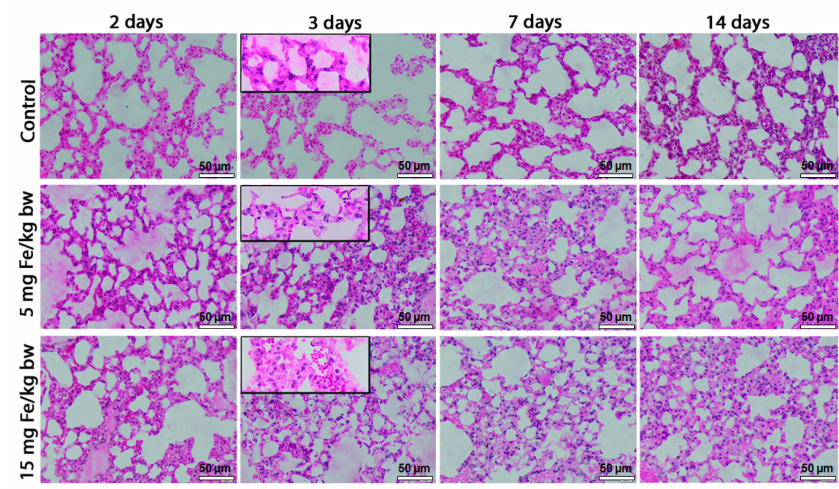
Figure 2. Histopathology of lung tissue after exposure to iron oxide nanoparticles coated with phospholipid-based polymeric micelles (IONPs-PM). Hematoxylin and Eosin (H&E) stain. Scale bar = 50 µ m.